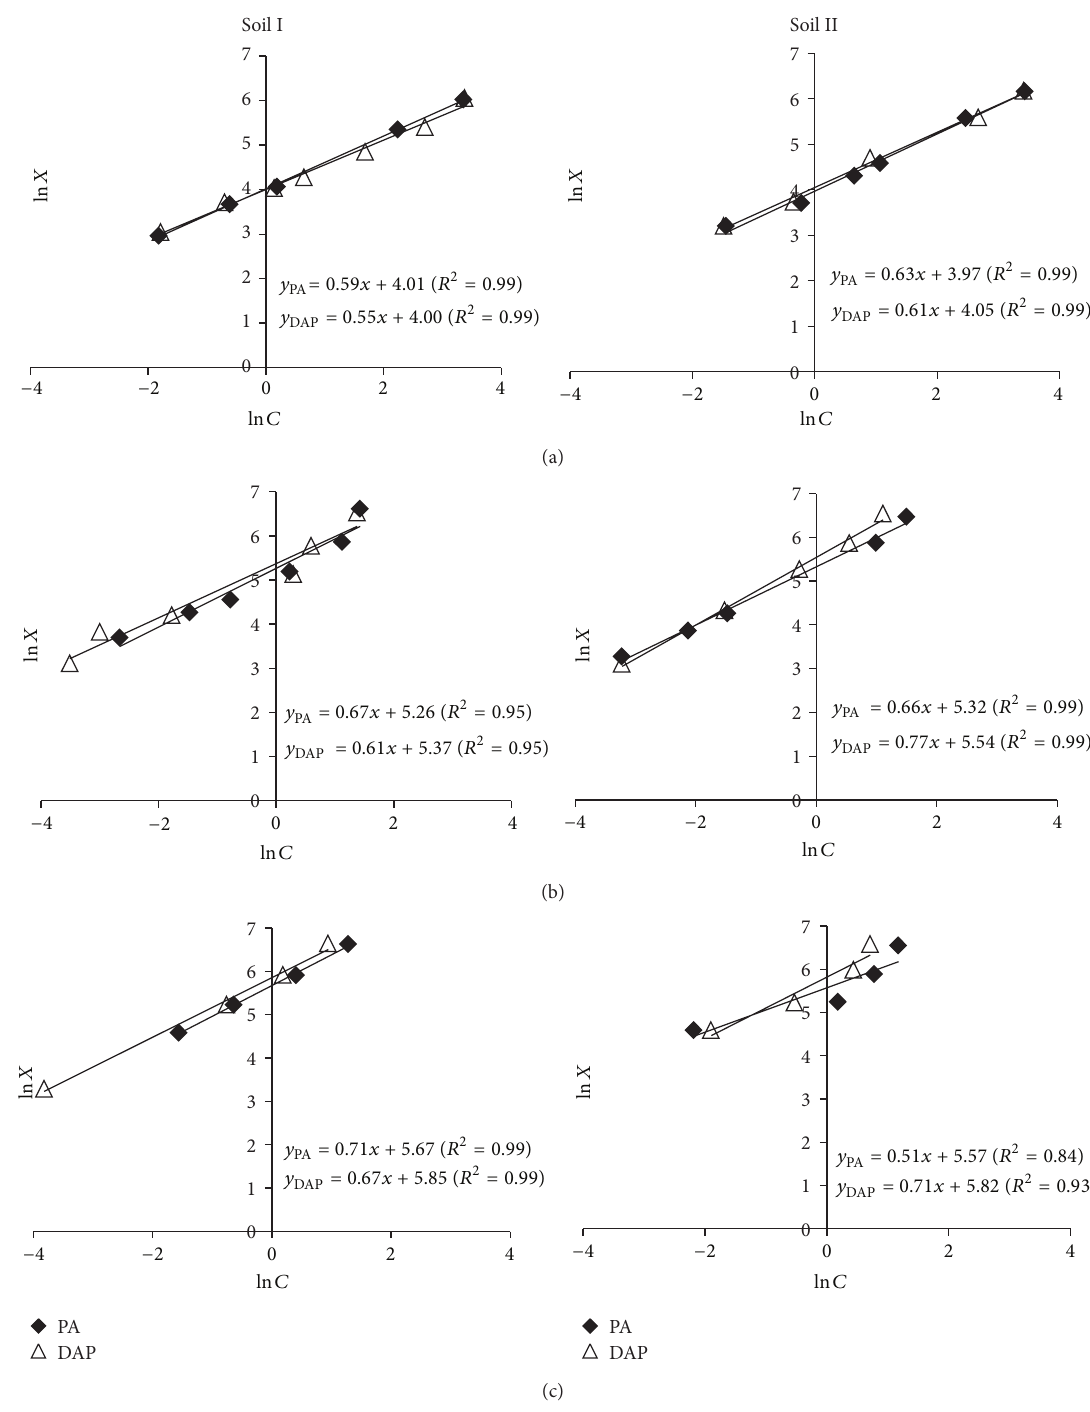
Figure 1: Freundlich isotherms for P adsorption: (a), (b), and (c) represent native, 10%, and 20% CaCO 3 , respectively. Table 2: Fitted Freundlich adsorption